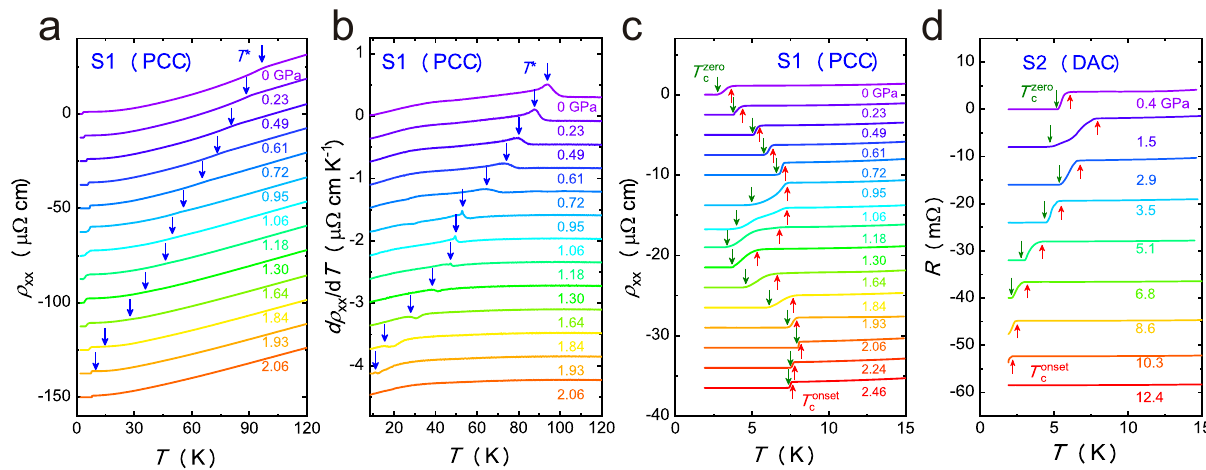
Fig. 1 Temperature dependence of resistivity in CsV 3 Sb 5 single crystals under high pressure. a Temperature dependences of resistivity under various pressures for sample 1 measured with PCC. b The derivative d ρ xx /dT curves under various pressures. The blue arrows indicate the CDW transition temperature T* . c , d The evolution of superconducting transition temperatures under pressure for sample 1 with PCC and sample 2 with DAC. The red and green arrows represent the T onset c and T zero c , respectively. All the curves were shifted vertically for clarity.